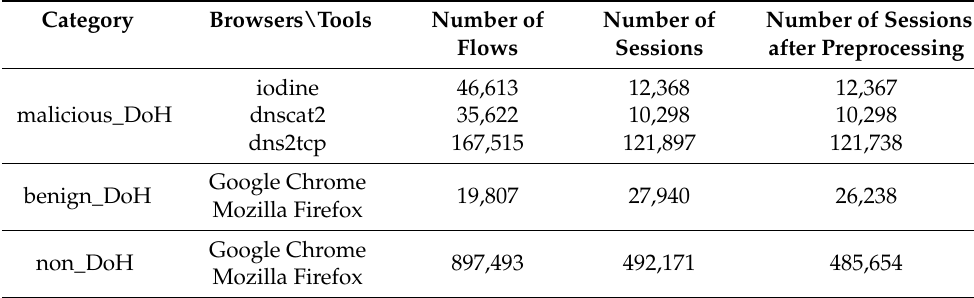
Table 3. CIRA-CIC-DoHBrw-2020 dataset and preprocessing